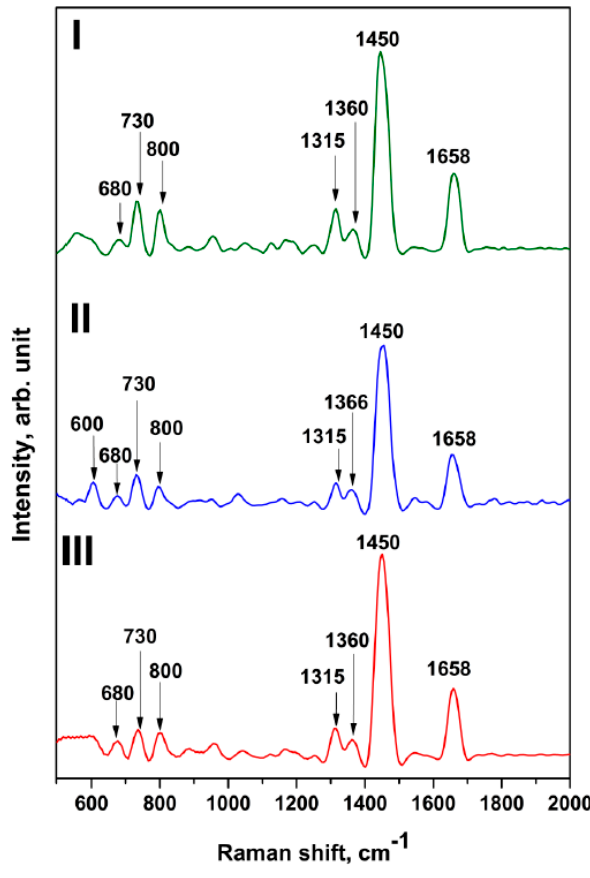
Figure 9. Raman spectra of resins varieties I, II and III from the island of Sumatra.